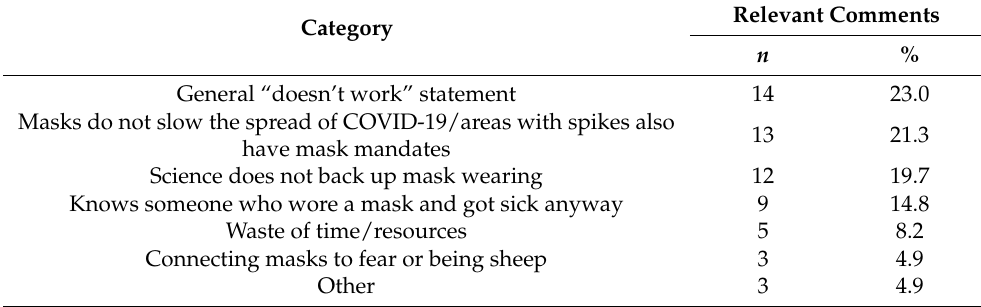
Table 5. Reasons for mask refusal.